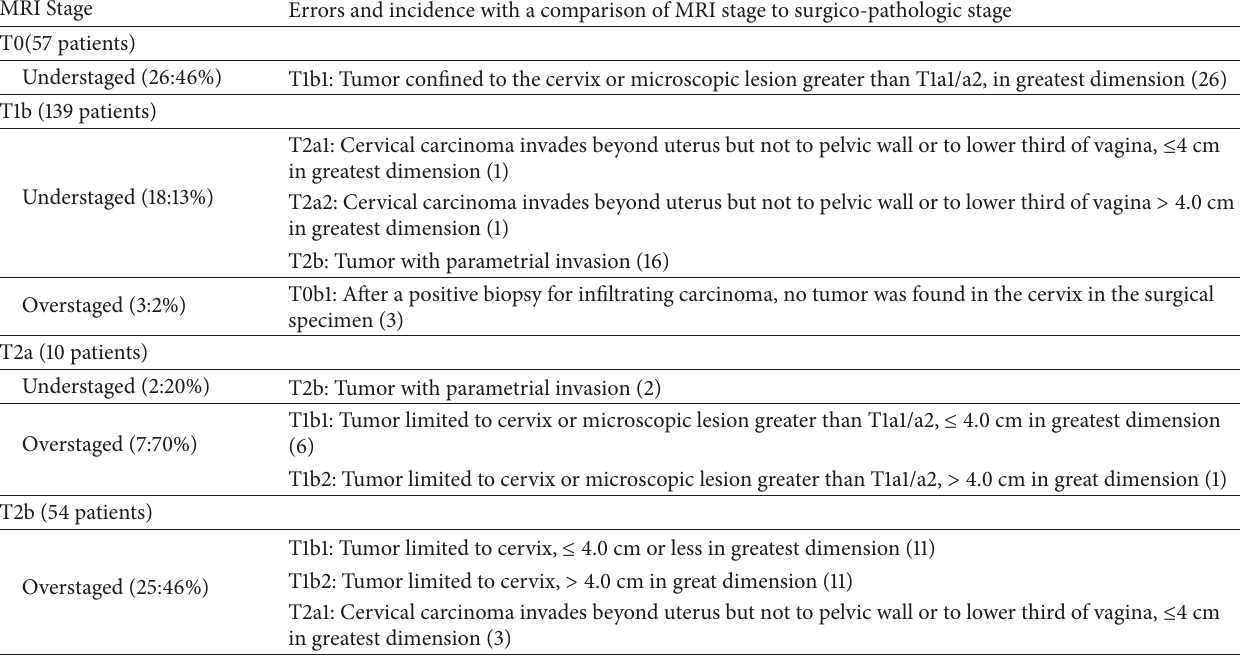
Table 5: Incidence of staging errors. Errors and incidence with a comparison of MRI stage to surgico-pathologic stage